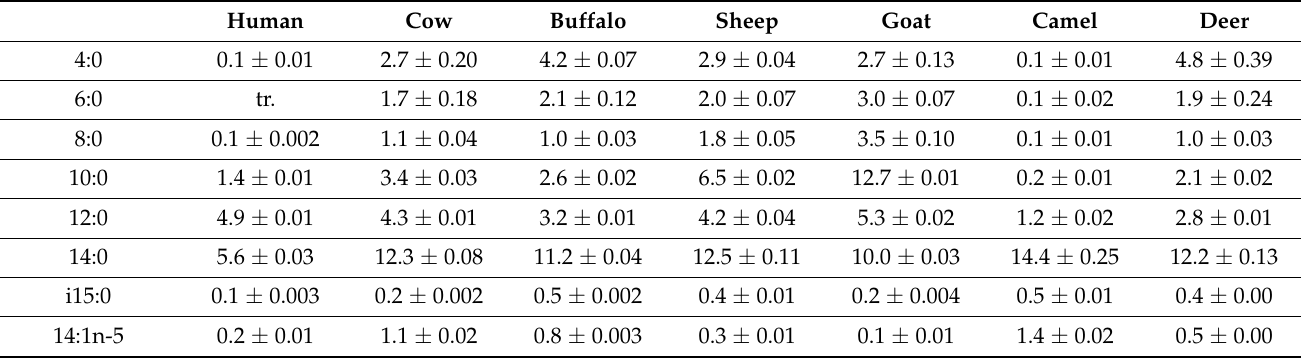
Table 1. Fatty acid composition of the milk samples studied (in weight % of total fatty acids, with only those above 0.1% in at least one of the samples